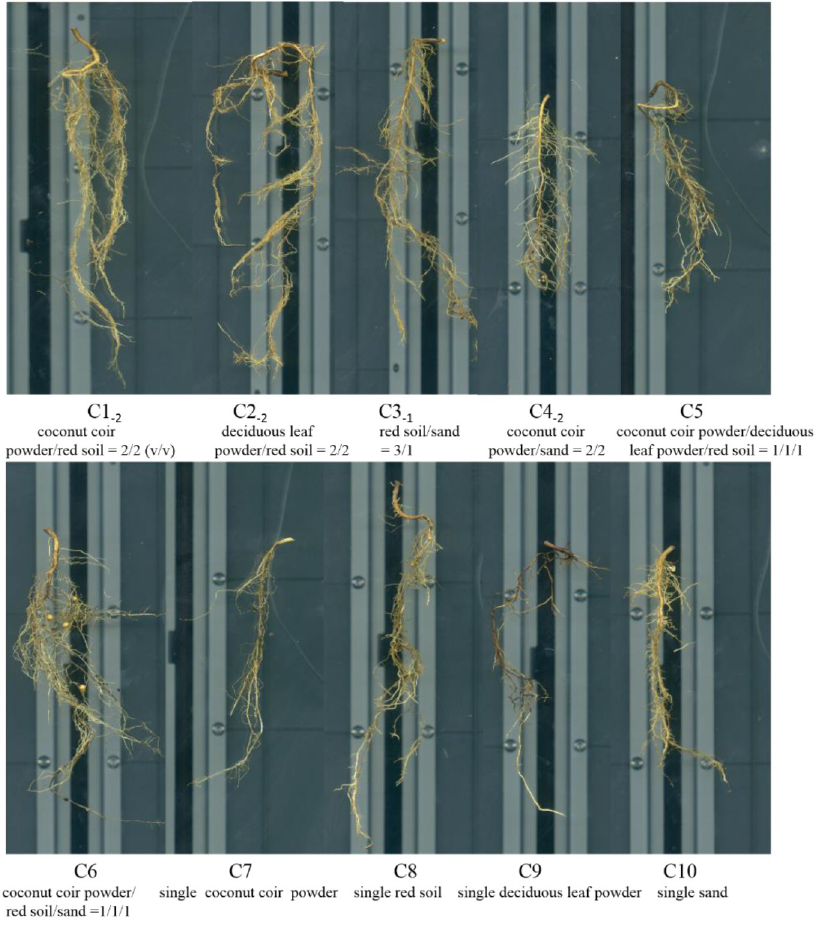
Fig 2. Below-ground morphological traits of D . odorifera cultured by different